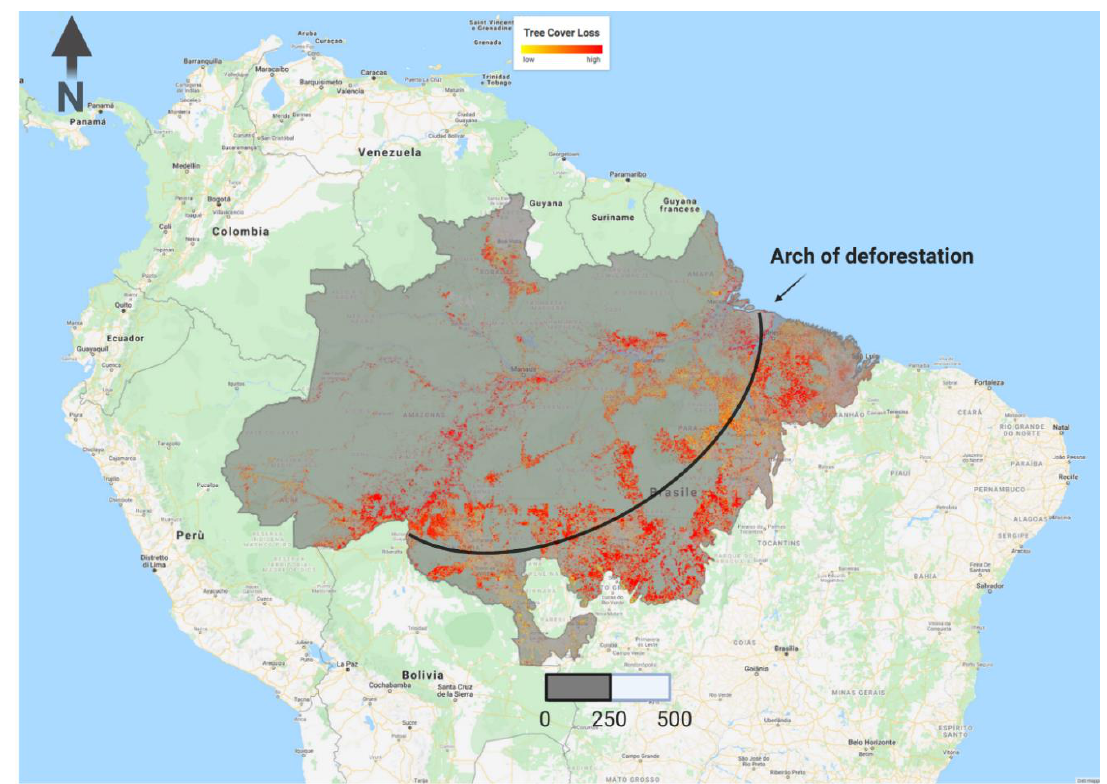
Figure 2. Study area: Amazonian forest in Brazil. Amazon biome extent (gray area). Forest loss map (yellow-red) has been displayed according to [45,46] (Global Forest Change dataset in Google Earth Engine). Red pixels identify areas of where tree cover loss has been detected.